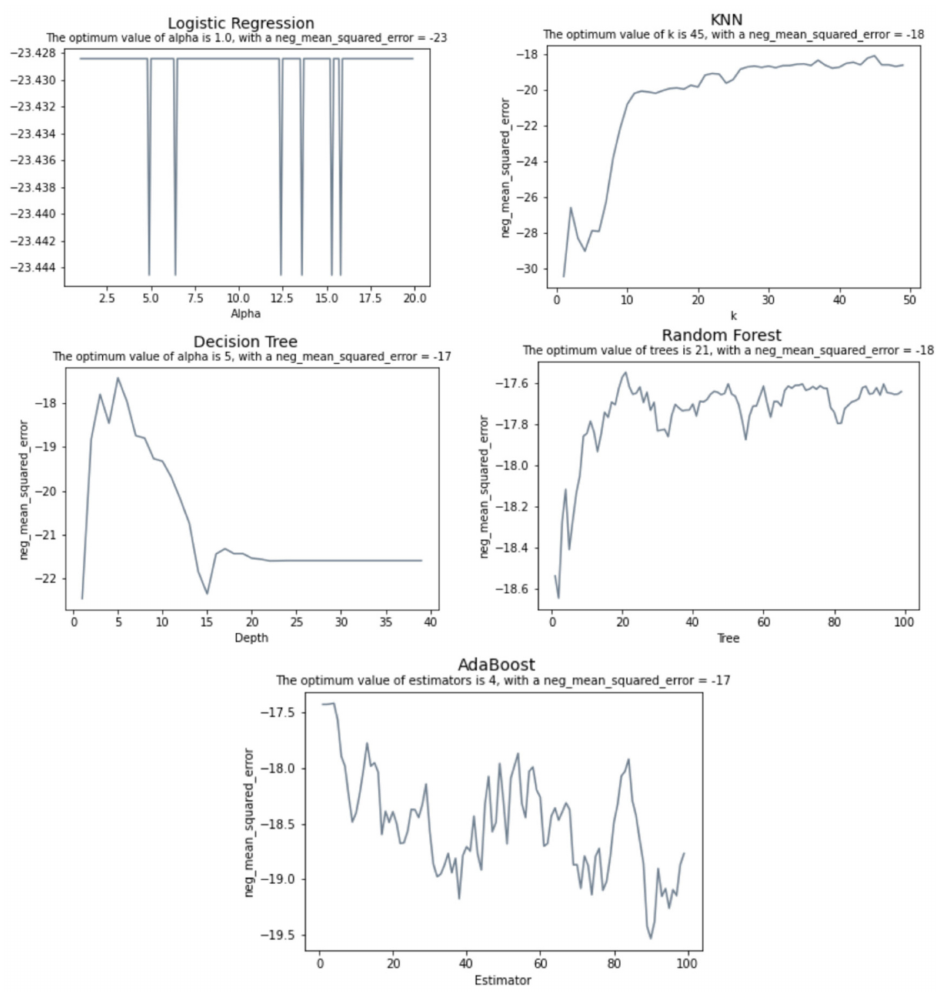
Figure 11. Hyperparameter tuning.